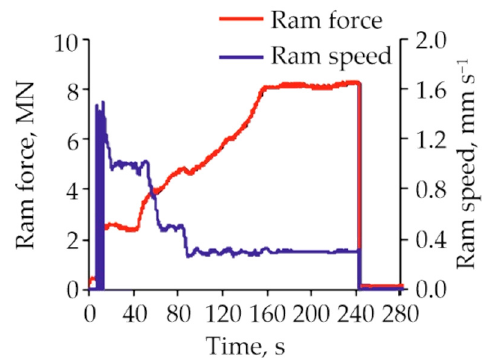
Figure 6. Evolution of ram force during the course of a LACE process with an extrusion ratio of 11:1 and adjustments of ram and adjustments of ram speed.